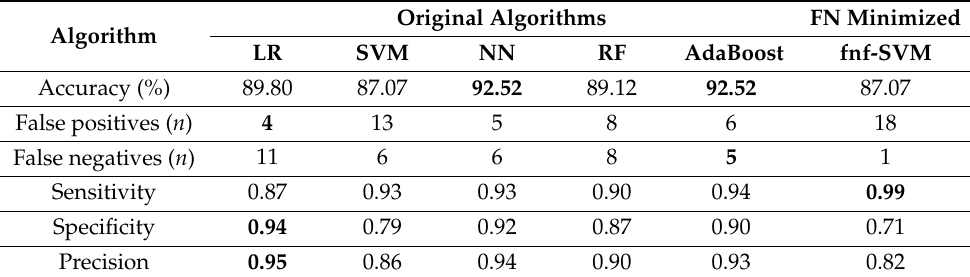
Table 2. Best obtained results with the different machine learning